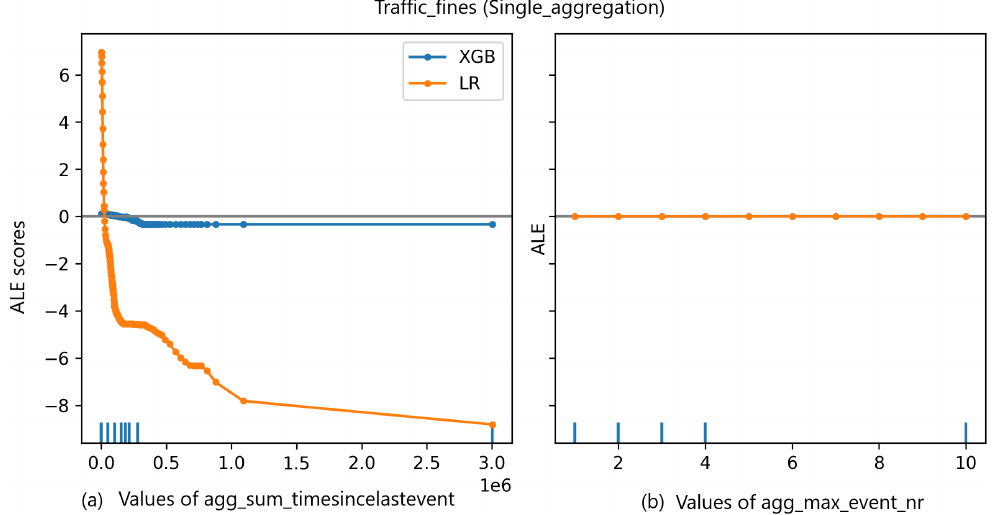
Figure 5. ALE plot of Traffic_fines event